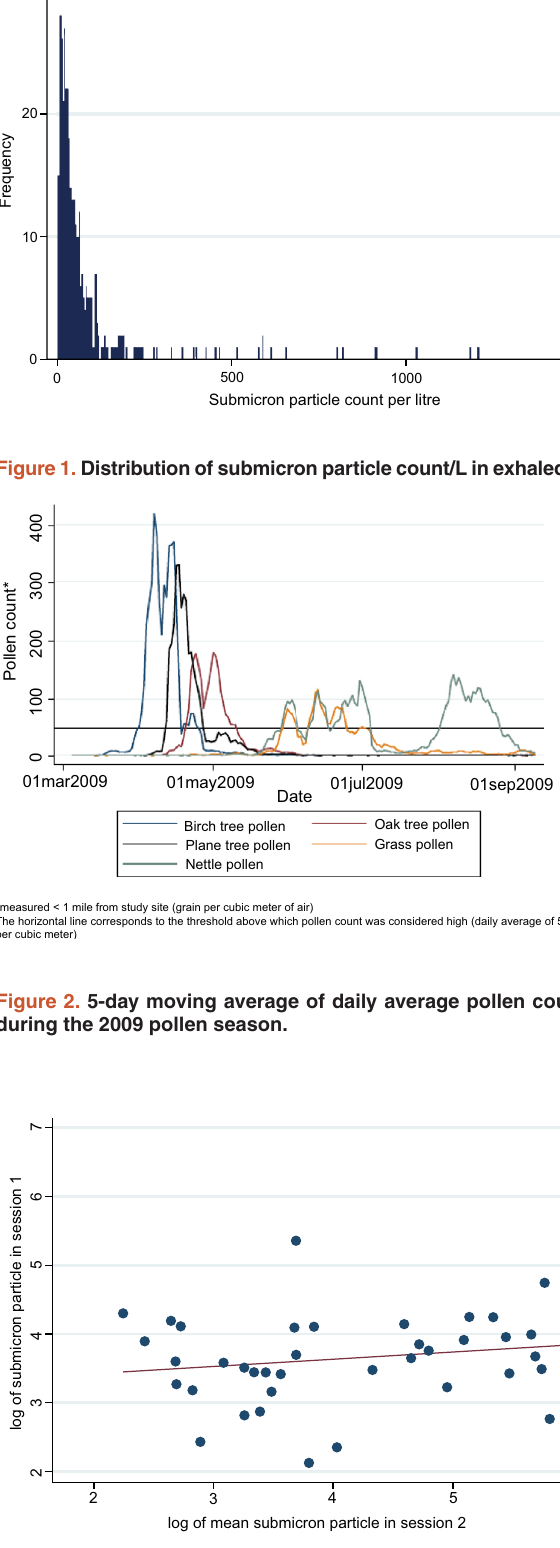
Figure 3. Stability of bio-aerosol production: scatterplot of mean submicron particle count per participant between sessions 1 and